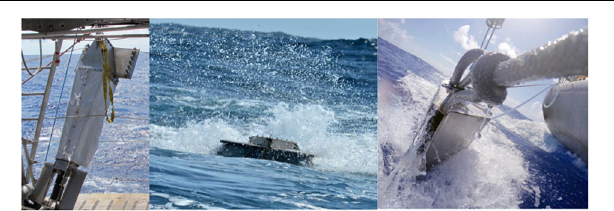
FIGURE 4 | Surface net and water samplers. The High Speed Net on board and in work ( left and middle ), and the “Dolphin” (right) deployed simultaneously. The Dolphin is connected to a large volume peristaltic pump installed on the deck for surface water sampling (Photos from left to right F. Lombard, F. Aurat, J.M. Flores.)